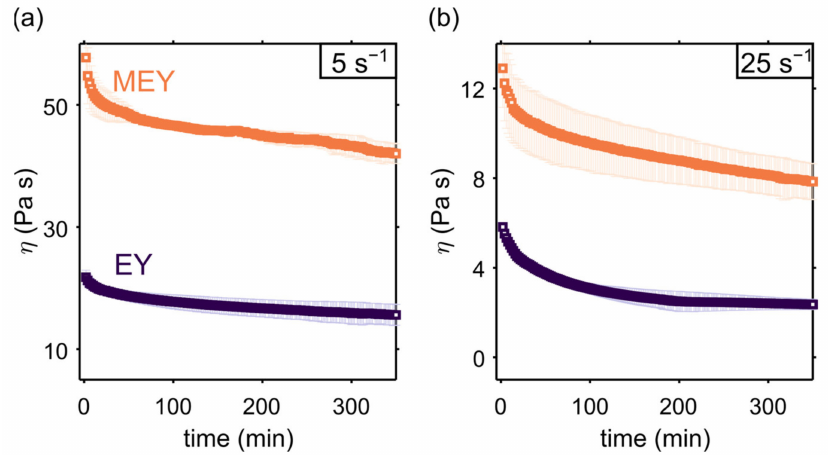
Figure 1. Apparent viscosity measurements of EY (dark purple) and MEY (orange) emulsion formu- lations as a function of time, performed at a constant shear rate of 5 s − 1 ( a ) and 25 s − 1 ( b ) using a Couette cell geometry (gap size 1 mm). Symbols refer to means over two replicates, and error bars represent the deviation range.